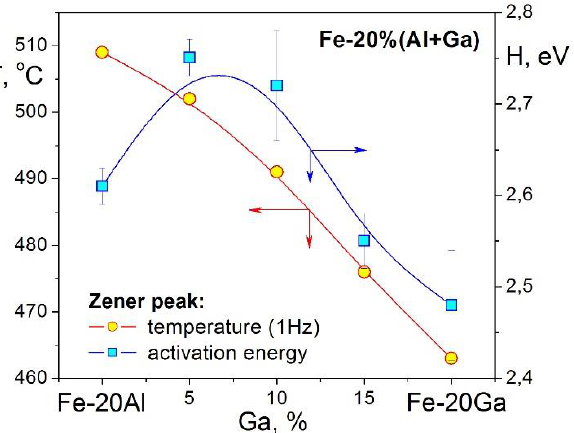
Figure 13. Change of the Zener peak temperature ( left scale) and activation energy ( right ) in Fe- 20%(Al+Ga) alloys.